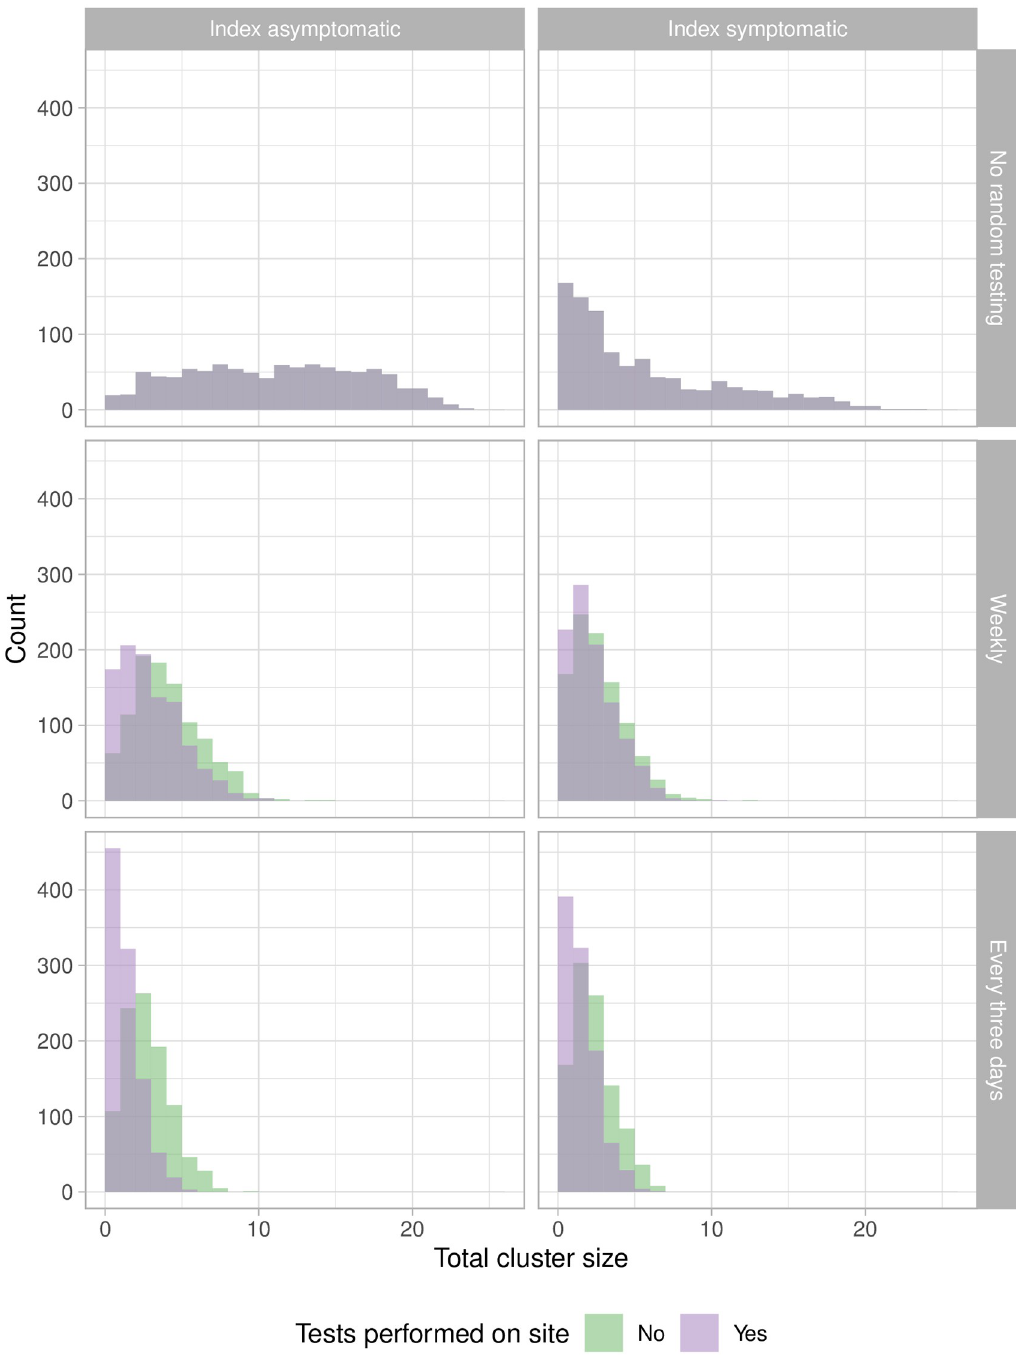
Fig 6. Cluster sizes are greatly reduced with regular universal (e.g. pooled) testing, particularly when that testing is performed on site (in the model, in 2 hours, compared to an assumed 2-day time to result for tests processed off site). Left: index case symptomatic. Right: index case asymptomatic. The baseline scenario shows the cluster sizes without regular testing, compared to weekly (middle row) or every 3 days (bottom row). Regular testing reduces the median cluster size from 4 or 12 (index symptomatic, asymptomatic) to 3 if testing is done offsite, or 2 if it is performed rapidly on site. The fraction of clusters of size > 5 is reduced from 80% to 20% (or 12% for rapid onsite testing) if the index is asymptomatic, and from 48% to just 2–3% if the index is